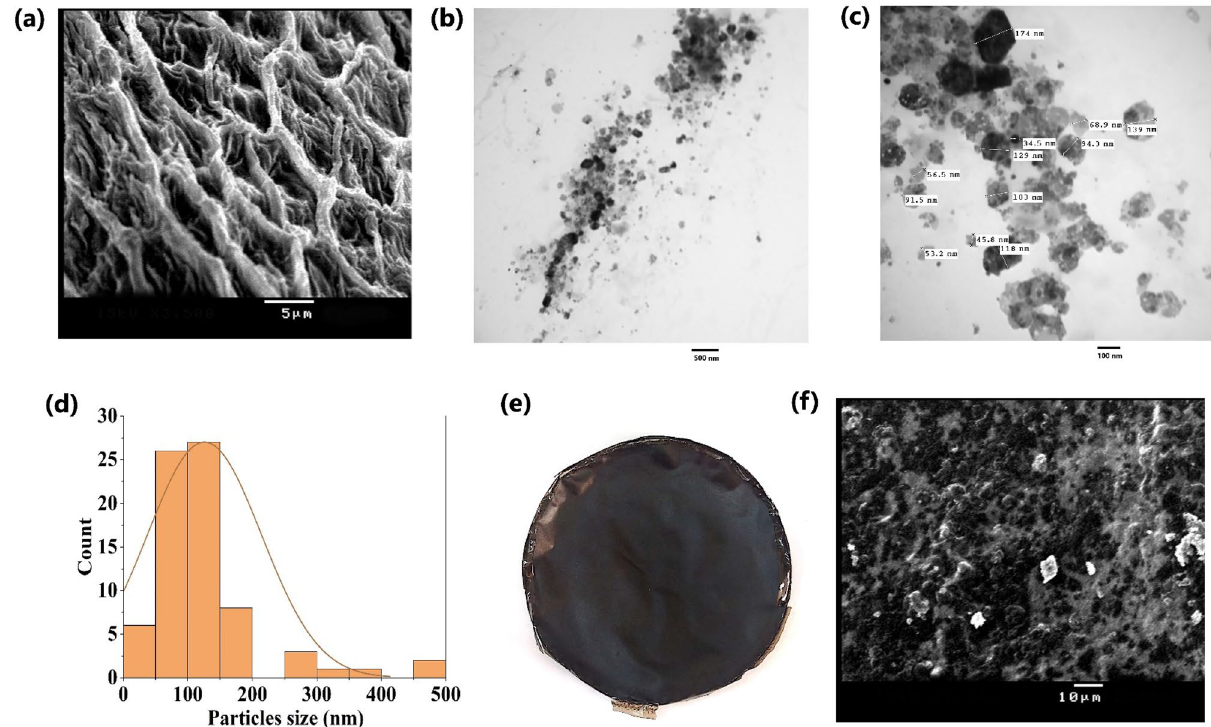
Figure 1. ( a ) SEM image of the cellulose extracted from Ulva lactuca , ( b ) and ( c ) TEM images of cellulose nanocrystals, ( d ) Particle size distribution of cellulose nanocrystals, ( e ) Optical micrograph of cellulose nanocrystals-graphene oxide composite film, ( f ) SEM image of the cellulose nanocrystals-graphene oxide